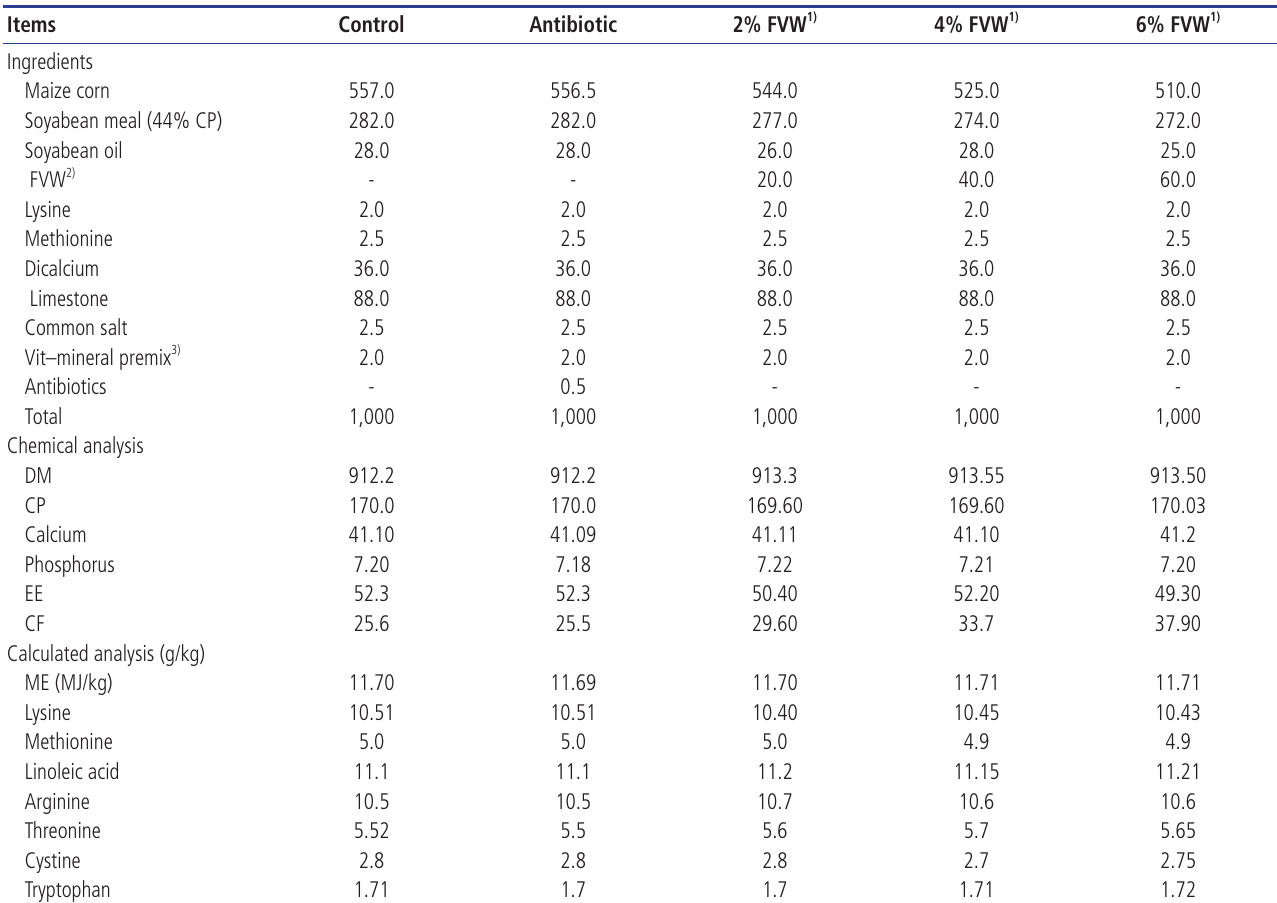
Table 1. Ingredients and nutrient composition of the diets for layers (g/kg) Items